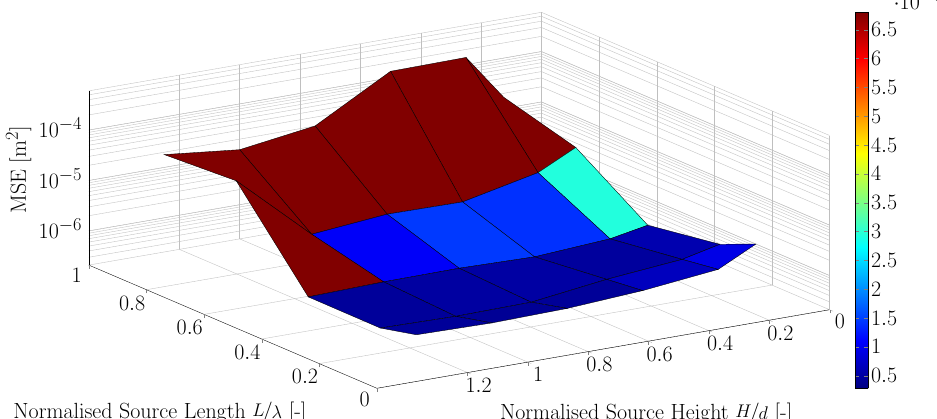
Figure 7. Intermediate water case. Source centre at d of 1 d and source length 1